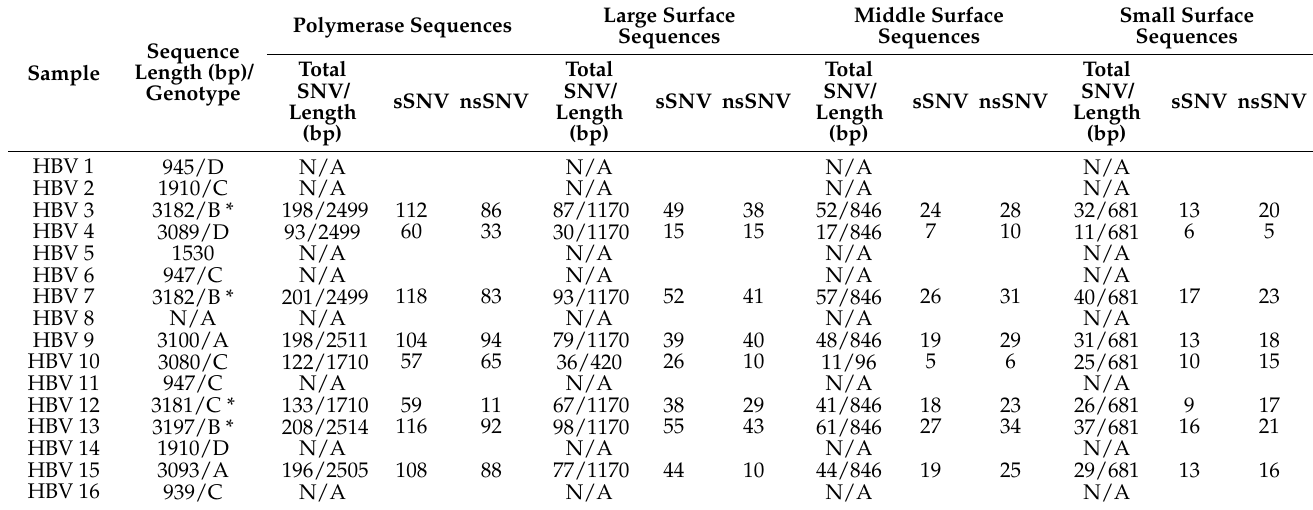
Table 3. Number of sSNV and nsSNV identified inside the polymerase and large/middle/small surface coding sequences of HBV sequences from our samples, compared to the NCBI reference